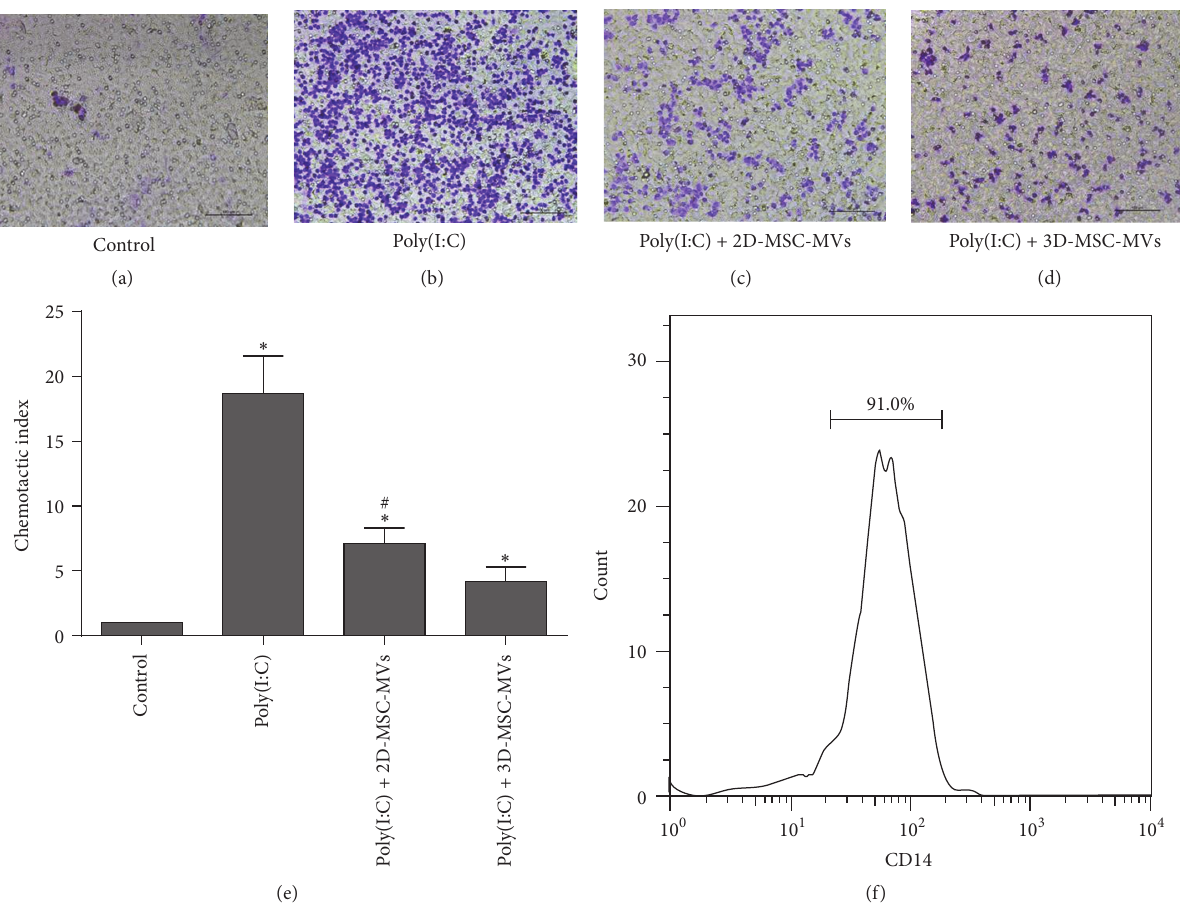
Figure 6: The chemotactic activity of poly(I:C) to CD14 cells and the influence of 2D-MSC-MVs and 3D-MSC-MVs on CD14 cells migration. (a)–(d) Light microscopic images showing poly(I:C) solution (b) significantly induced the CD14 cells migration and compared to 2D-MSC- MVs (c), 3D-MSC-MVs (d) could significantly decrease the migration of CD14 cells. Scale bar = 100um. (e) Quantification of transwell migration of CD14 cells. (f) Through flow cytometry, the purity of CD14+ cells was validated and higher than 90%. ∗ denotes significant differences between control and each group of 𝑝 value less than 0.05. # denotes significant differences between 2D-MSC-MVs and 3D-MSC- MVs group of 𝑝 value less than